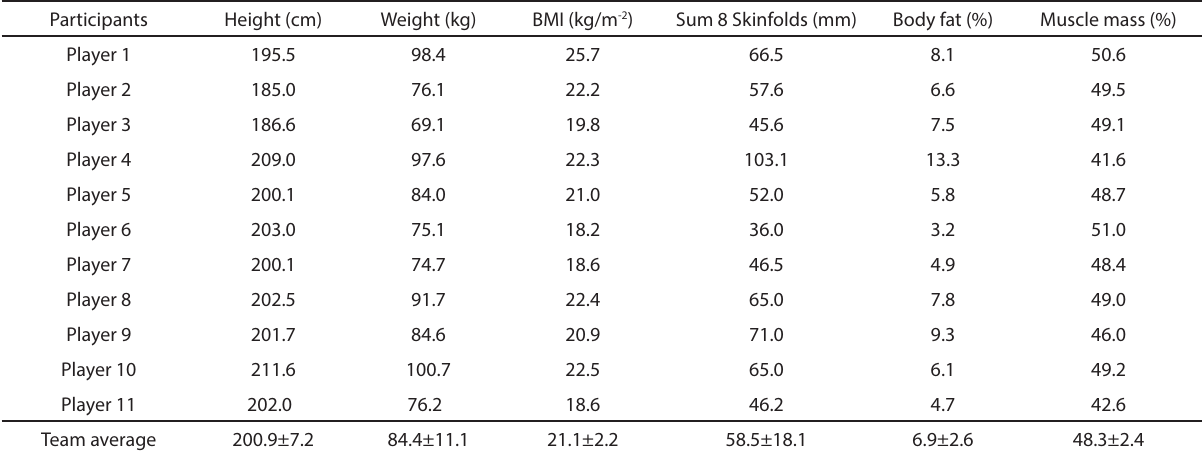
Table 1. Anthropometric values of the players participating in the study. Total values are presented as mean ± standard deviation (SD)